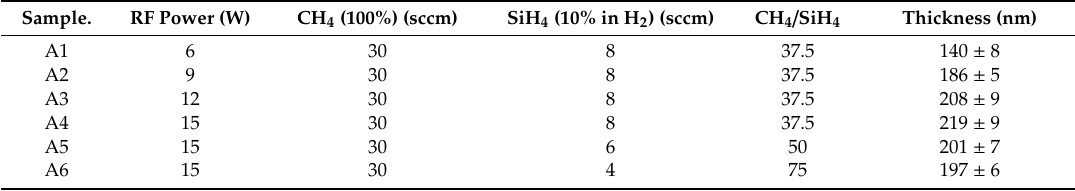
Table 1. Deposition parameters of a-Si 1 − x C x :H films deposited by RF PECVD at 150 ◦ C.